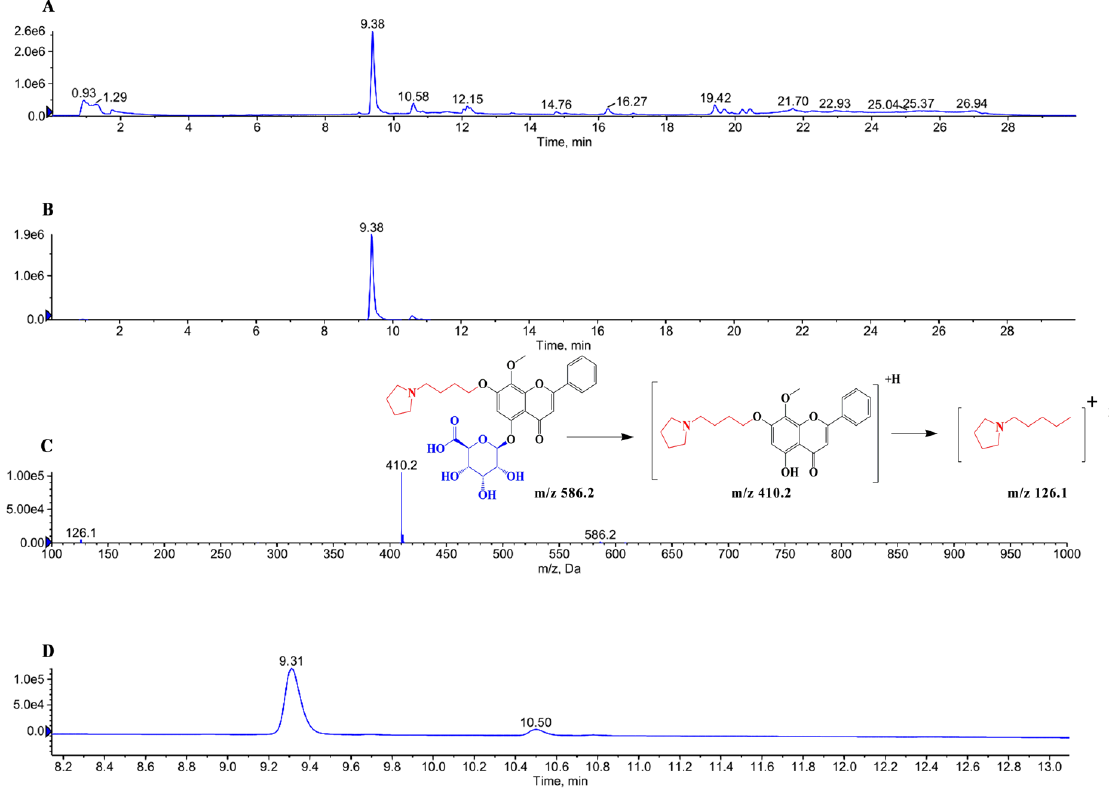
Figure 1. HPLC-UV-TripleTOF analysis of GL-V9 and its metabolites in HLMs system: ( A ) Total ion current chromatogram; ( B ) extracted ion current chromatogram; ( C ) spectrum of 5- O -glucorunide GL-V9; ( D ) UV chromatogram). The structure of 5- O -glucorunide GL-V9 and predominant fragmentation pattern was shown in C, and the fragment drawn in red is the chemical modification in GL-V9, while the fragment in blue is the glucuronic acid part.